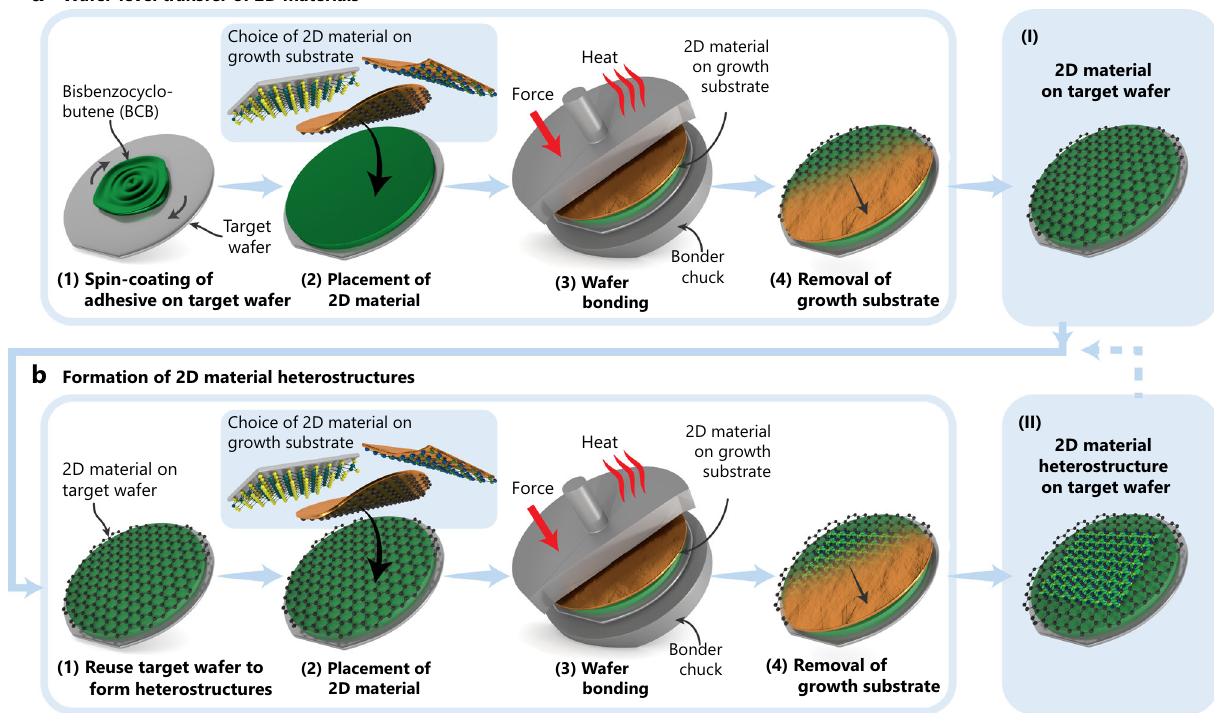
Fig. 1 Schematics illustration of the methodology for wafer-level transfer of two-dimensional (2D) materials and formation of 2D material heterostructures. a Wafer-level transfer of materials. (1) Spin coating and soft baking of thermosetting bisbenzocyclobutene (BCB) as an adhesive layer on the target wafer. (2) Placement of the 2D material on its growth substrate on top of the target wafer, with the 2D material facing the target wafer. (3) Adhesive wafer bonding by applying heat and force to the wafer stack using a commercial semiconductor wafer bonding tool, thereby forming a stable bond between the 2D material on its growth substrate and the target wafer. (4) Removal of the growth substrate. (I) Transferred 2D material on the target wafer. b Formation of 2D material heterostructures. (1) Reusing the target wafer from step (I) without additional treatment. (2) Placement of a second 2D material on its growth substrate on top of the target wafer, with the 2D material facing the previously transferred 2D material. (3) Wafer bonding as in a) step (3). (4) Removing the growth substrate of the second 2D material. (II) Transferred 2D material heterostructure on the target